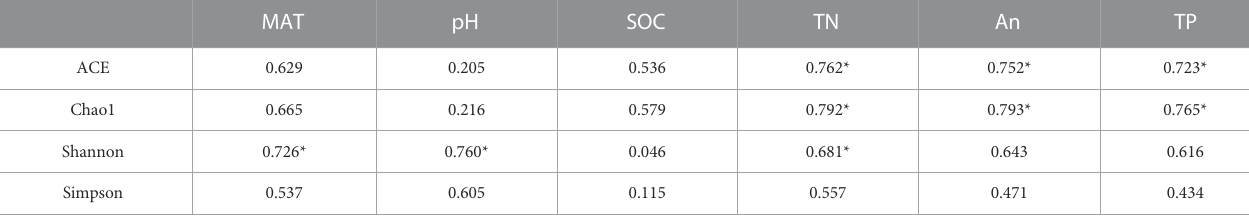
TABLE 4 Correlation coef fi cients of bacterial alpha diversity indices and soil chemical